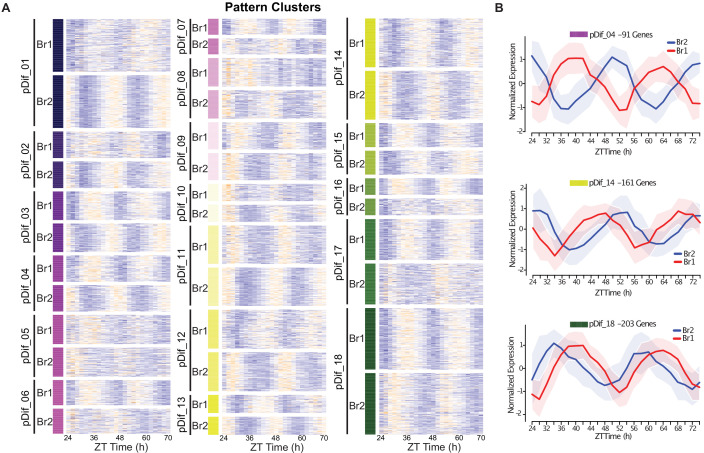
Divergence in phase domains among retained paralogs.(A) Heatmap of the results from the DiPALM differential pattern analysis (pDif) clustering showing the changes in expression pattern for paralogous pairs. The Br1 and Br2 heatmap blocks for each module contain matching paralogous pairs; for example, the gene in the first line of Br1 and Br2 heatmaps for module pDif_01 are paralogs. The blocks have been stacked on top of each other to be able to compare the change in pattern across the time course. Three-copy paralogs were split into three two-way comparisons. Expression values are log2 transformed FPKM values and the expression is arranged by ZT time across the x-axis. Higher expression levels are in orange and low expression levels are in purple. For example, pDif_01 shows paralogous pairs that are anti-phase with Br1 paralogs peaking at ZT36 and ZT60 and Br2 paralogs peaking at ZT24 and ZT48. (B) Line plots showing the expression patterns for three modules (pDif_04, pDif_14, and pDif_18). Each plot shows the normalized expression of paralogous pairs for all the genes in the module. Ribbons (shaded regions) represent the standard deviation.